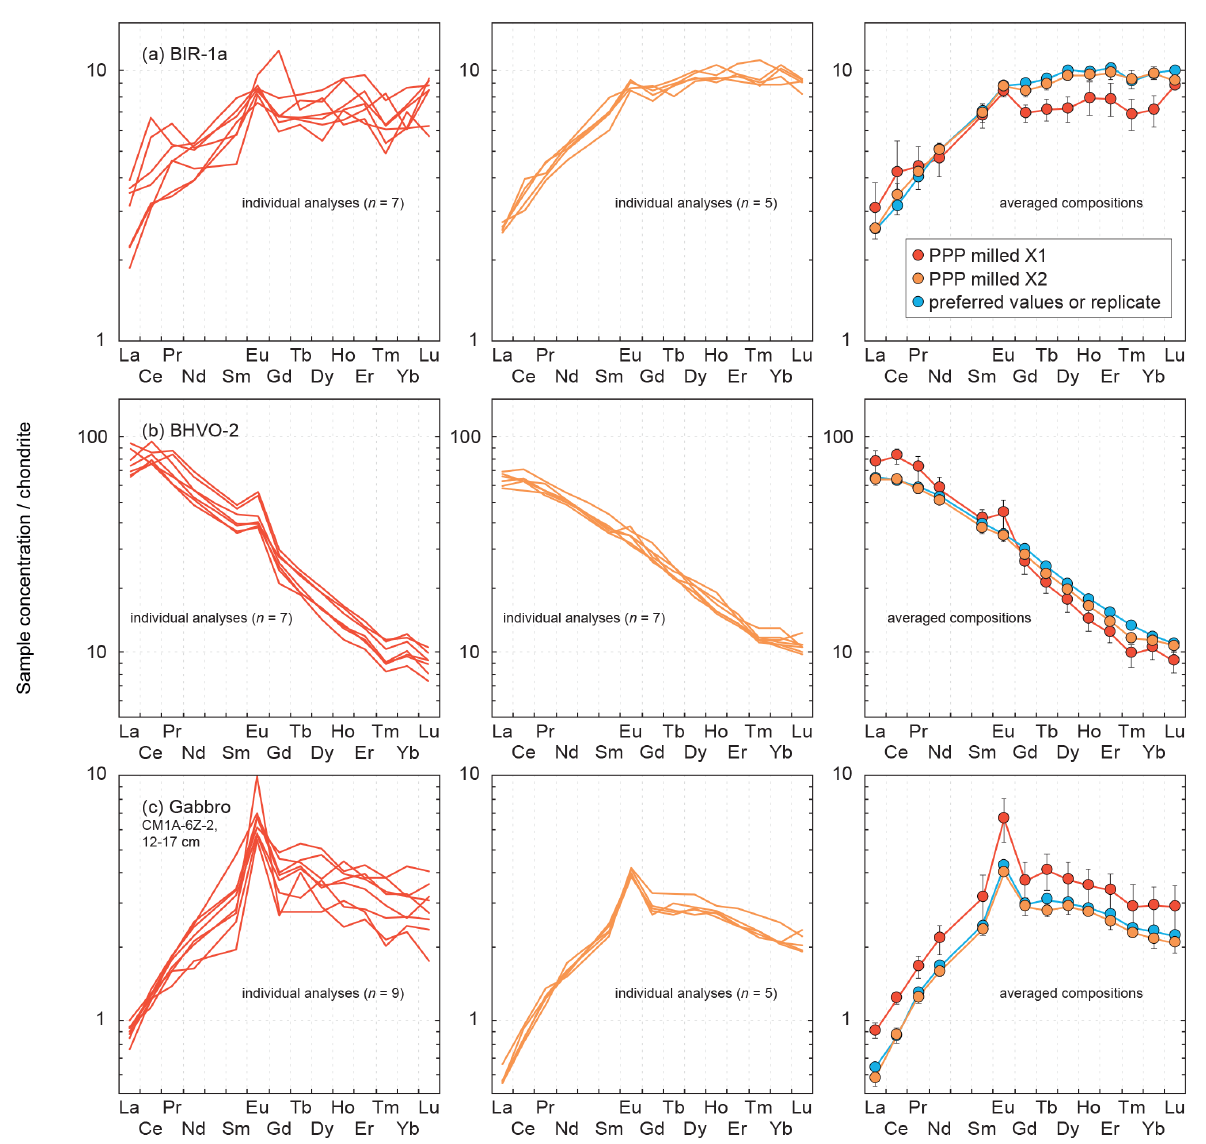
Figure 11. Comparison of the chondrite-normalized (normalization values from Barrat et al., 2012) REE patterns obtained for the reference materials (a) BIR-1a and (b) BHVO-2 and for (c) the gabbro CM1A-6Z-2, 12–17cm after LA-ICP-MS analyses of one-time milled pressed powder pellets (left) and of two-time milled pressed powder pellets (centre). The determined concentrations show a greater variability after only one milling step, and the averaged compositions (right) differ significantly from the results obtained both after the second-step milling and for the